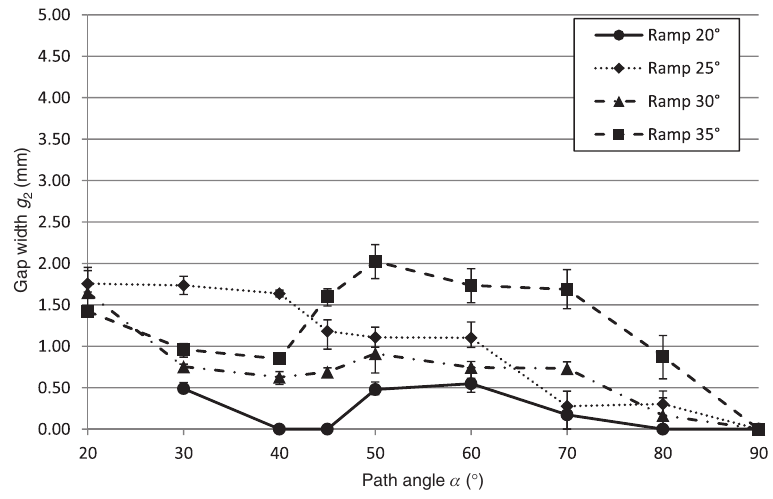
at the center of the ramp compared to analytical results. 1